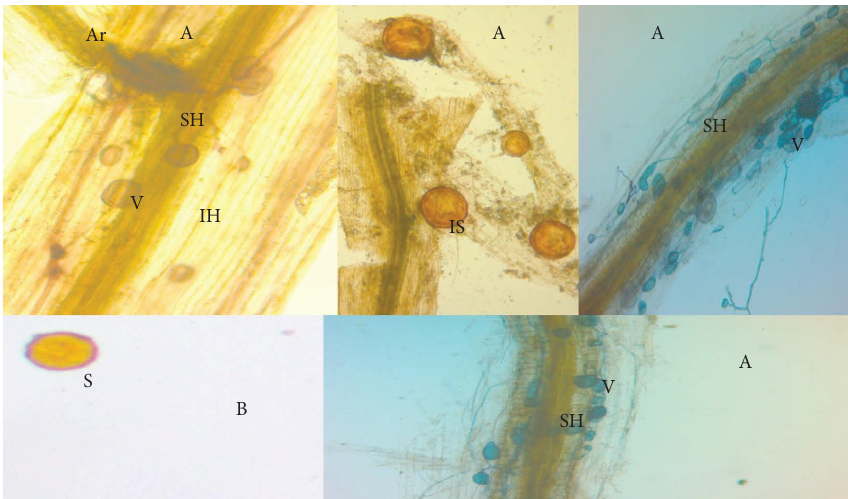
Figure 1: Morphology of AMF spore before being used as a treatment in tomato plants under drought stress. (A) Colonization structure of AMF within the roots, subtending hyphae (SH), intact spore (IS), vesicle (V), intraradical hyphae (IH), arbuscules (Ar), and spore (S). (B) Morphology of AMF spore in soil sample.